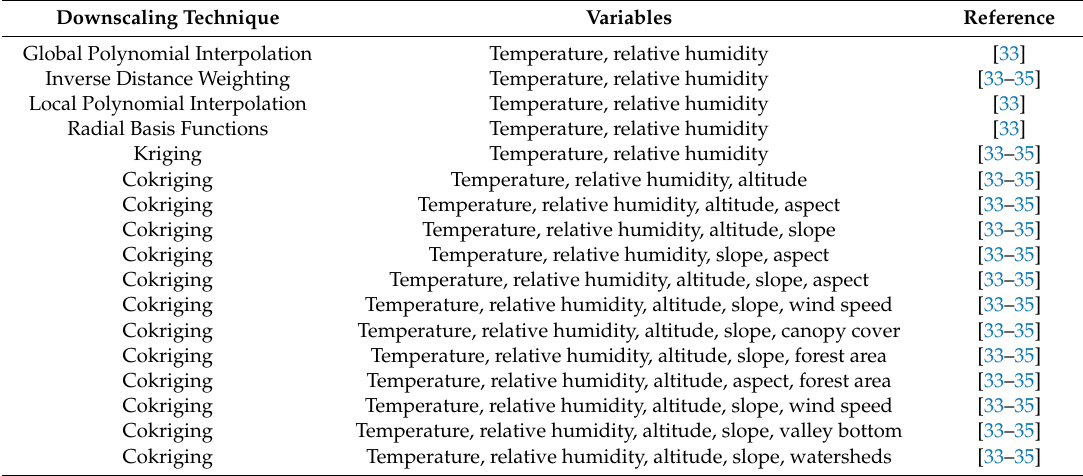
Table 1. Statistical downscaling techniques applied for the study area.